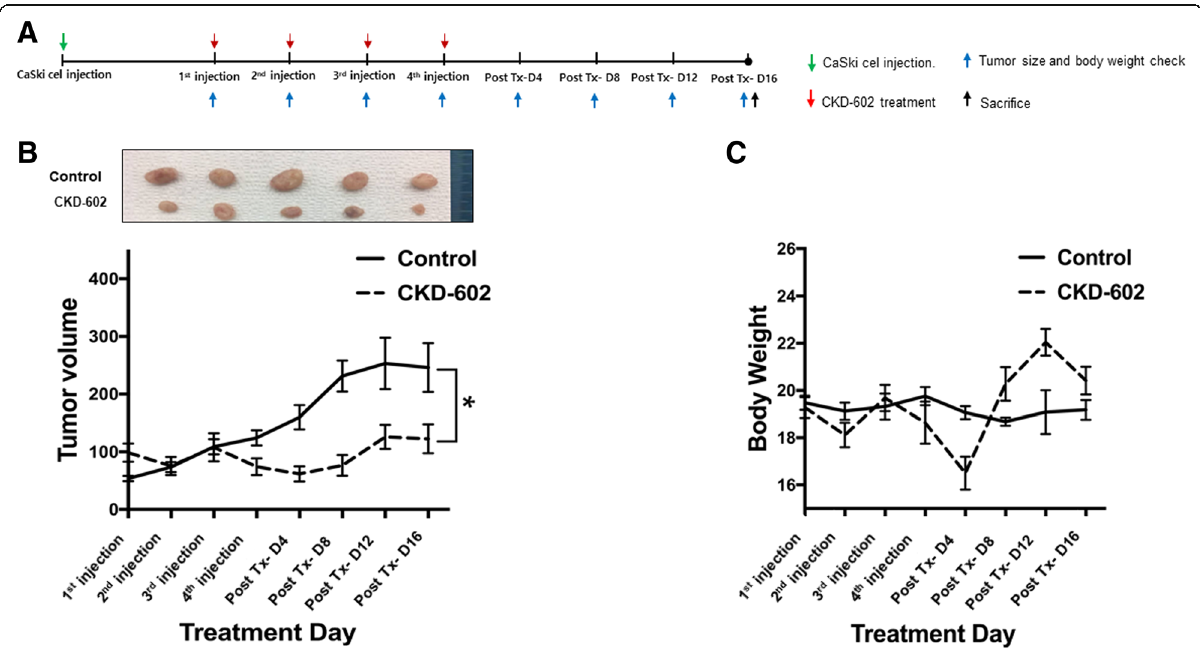
Fig. 4 Antitumor efficacy of CKD-602 in a CaSKi xenograft model. a. Schematic diagram of the treatment regimen of CKD-602. Groups of BALB/c- nude mice (five per group) were subcutaneously challenged with CaSki 4 × 10 6 CaSki tumor cells per mouse. b. Tumor volume in CaSki tumor- bearing mice in control mice and the CKD-602-treated mice. Results are expressed as mean ± SEM (*p < 0.05). c. Body weight of CaSki tumor- bearing mice in control mice and CKD-602-treated